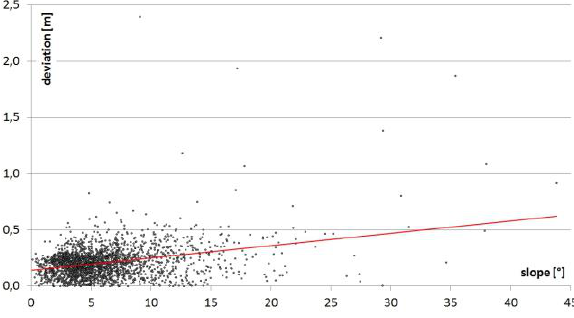
Figure 4. Distribution of deviation absolute values and regression